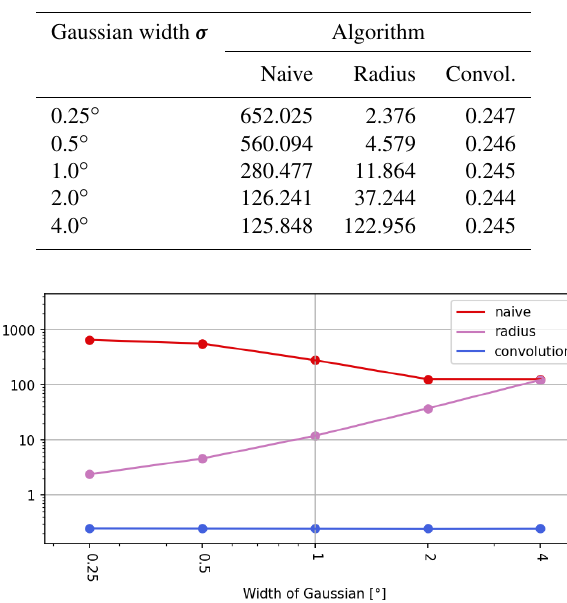
Table 3. Execution times (in s) of the investigated algorithms for varying Gaussian width parameters σ . The number of sample points N = 3490 and the grid size of 2400 × 1200 points with a resolution of 32points per degree are kept constant. The convolution algorithm applied a 4-fold convolution.